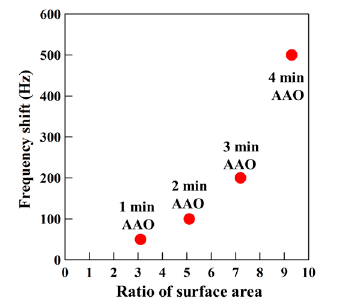
Figure 3. Frequency shift of the antigen-antibody interaction using the QCM with AAO nanostructure. Concentration of antigen (mouse IgG) was 10 μ g/mL in the all